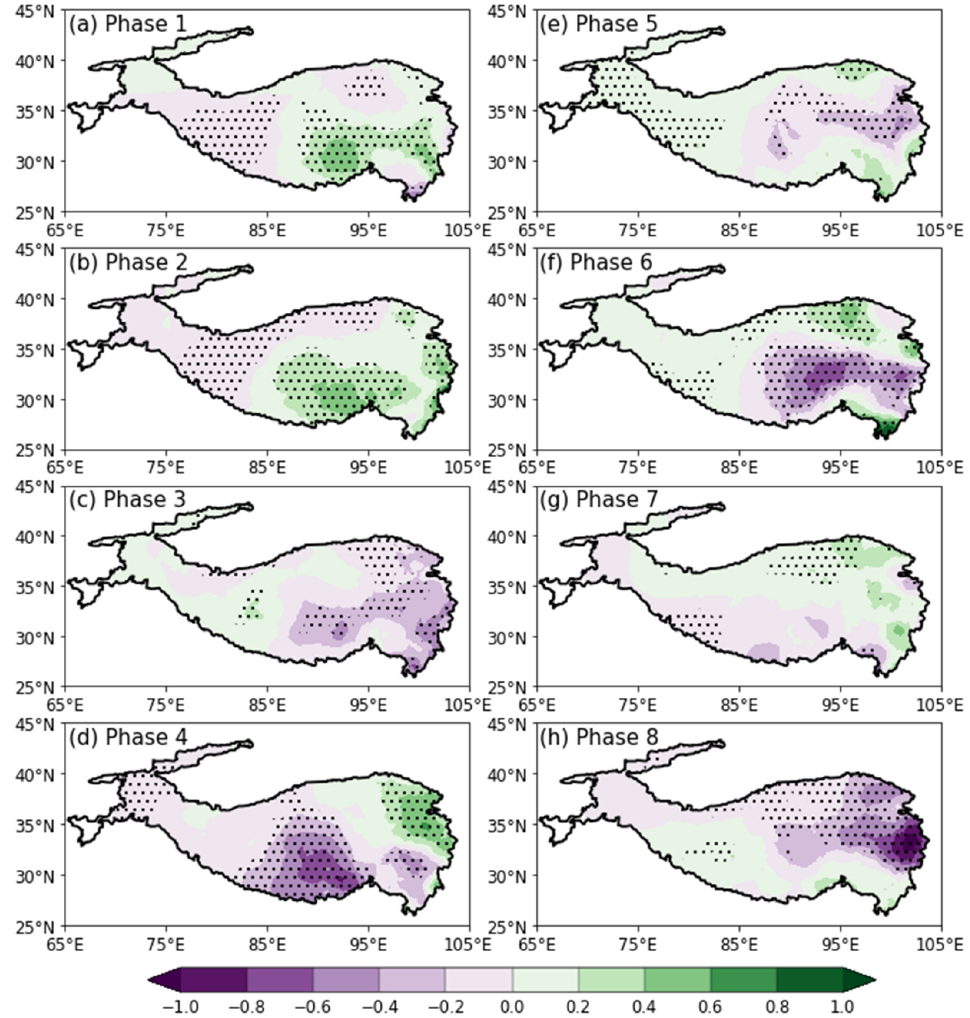
Figure 6. Composites of CN05.1-gridded precipitation anomalies (mm) in MJO Phases 1–8 ( a – h ) over TP in boreal summer during 1980–2020. Dots indicate values are statistically significant at the 95% confidence level.